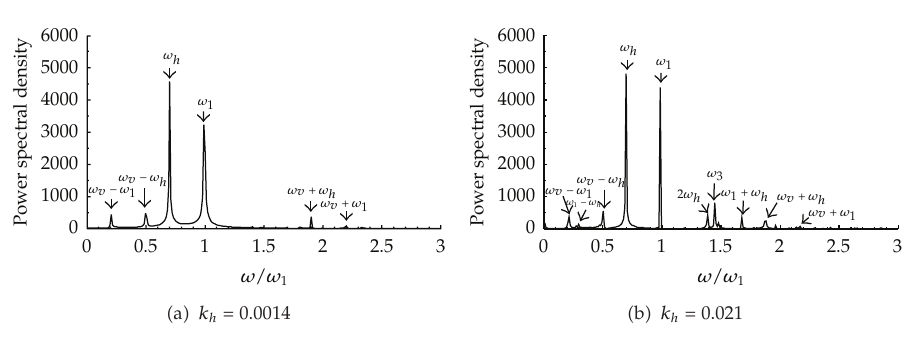
Figure 11: Spectral charts corresponding to the Figure 10.